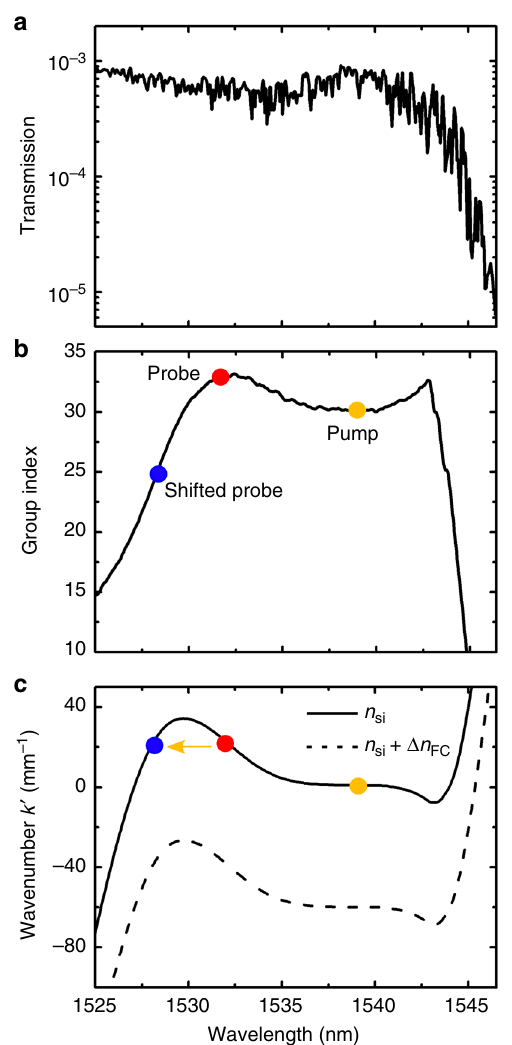
Fig. 2 Characteristics of the fabricated slow light silicon PhC waveguide. a Linear transmission and b measured group index. c The calculated dispersion band from the measured group index in b . The wave vector corrected by the slope of the pump group velocity is presented. Due to very small band diagram shift the curves cannot be presented in the original form similar to Fig. 1a. Solid curve represents the original dispersion band of waveguide mode with refractive index n si , while the dashed curve indicates the waveguide mode with refractive index change of ≈ − 3 × 10 − 3 . Dots indicate the locations of the input wavelengths of probe wave (red dot), pump pulse (orange dot) and the expected output wavelength of the shifted probe wave (blue dot) after the intraband transition took place. The orange line represents the phase continuity line with a slope equal to the travelling velocity of the pump pulse. Due to the slope correction, this